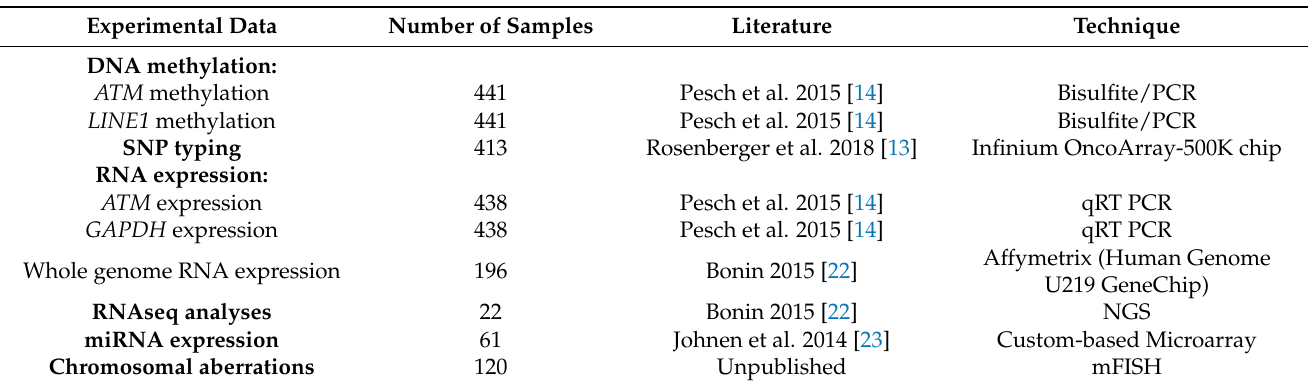
Table 2. Experimental data for individuals in